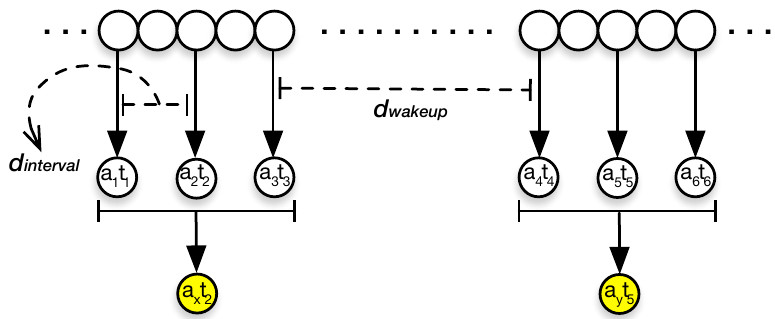
Figure 2. Ambient light calculation in three stages. Each circle represents a data point. = 10 min, our system samples three data points with d Every d wakeup t , a t , a t t , a t , a t each sampling, i.e. , a and a . The average of the three points is 1 1 2 2 3 3 4 4 5 5 6 6 t , a t stored with the timestamp of the middle point, i.e. , a x 2 y 5